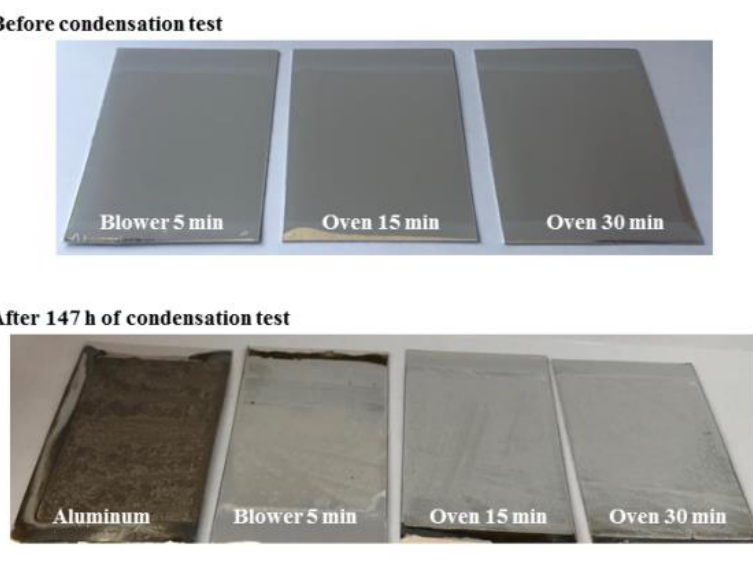
Figure 11. Variation of the hemispherical reflectance spectra of the Al/SiO 2 samples before and after 147 h of condensation test. Hemispherical reflectance spectra of the bare Al substrate after 147 h of condensation test (inset).